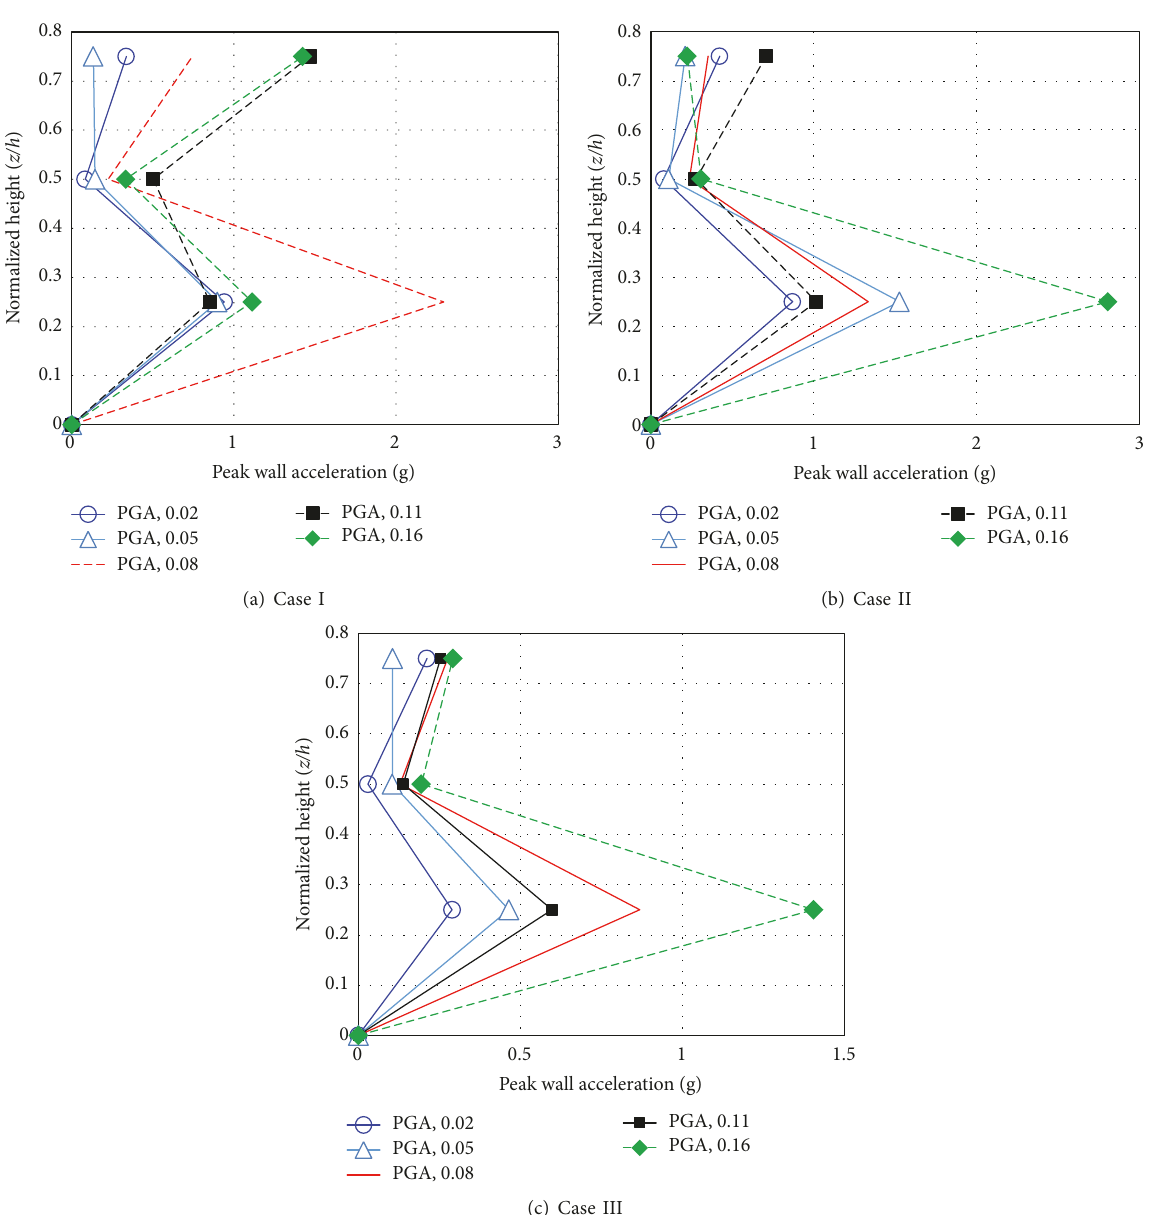
high-frequency component. This can induce severe effects on the low-rise brittle nonductile structures because of the large acceleration. Regarding the 1940 El-Centro record, high